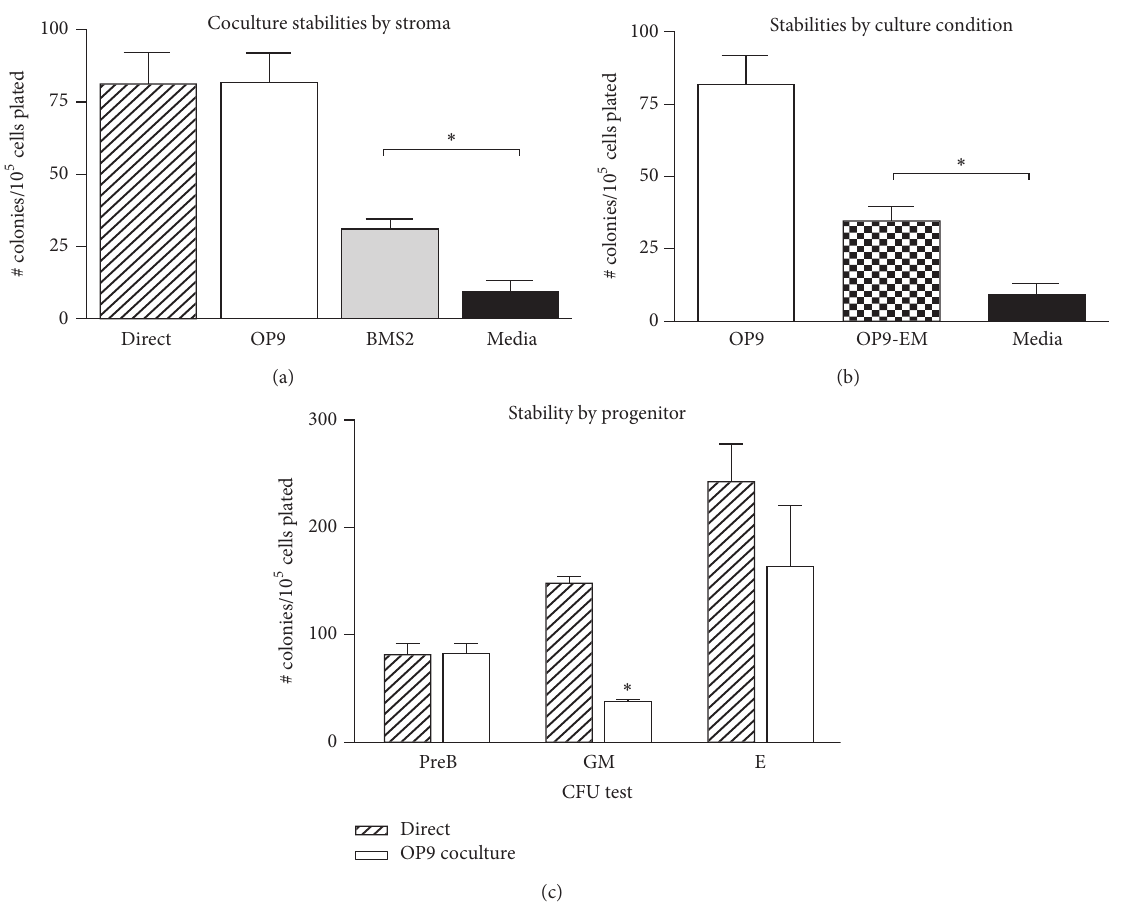
Figure 2: Conditions that sustain progenitor colony forming activities in collagenase-released bone marrow cells (BMC). (a) Comparison of PreB CFU activity in BMC maintained alone in culture media for 24 hours after isolation (media) or sustained by being cocultured for this period with an adherent monolayer of either OP9 cells or BMS2 cells. Direct cultures were placed in the methocult media immediately upon BMC isolation. ∗ 𝑝 < 0.05 . (b) BMC PreB CFU activity following 24-hour culture in media alone, in coculture with OP9 cells, or with media enriched by 24-hour preculture with OP9 cells (OP9-EM). ∗ Statistical significance; 𝑝 value < 0.05. (c) CFU progenitor cell proliferative activity (PreB, granulocyte-monocyte (GM), and erythroid (E)) in BMC, when directly isolated or after 24 hours in OP9 coculture. ∗ 𝑝 < 0.05 for comparison between direct BMC culture and OP9